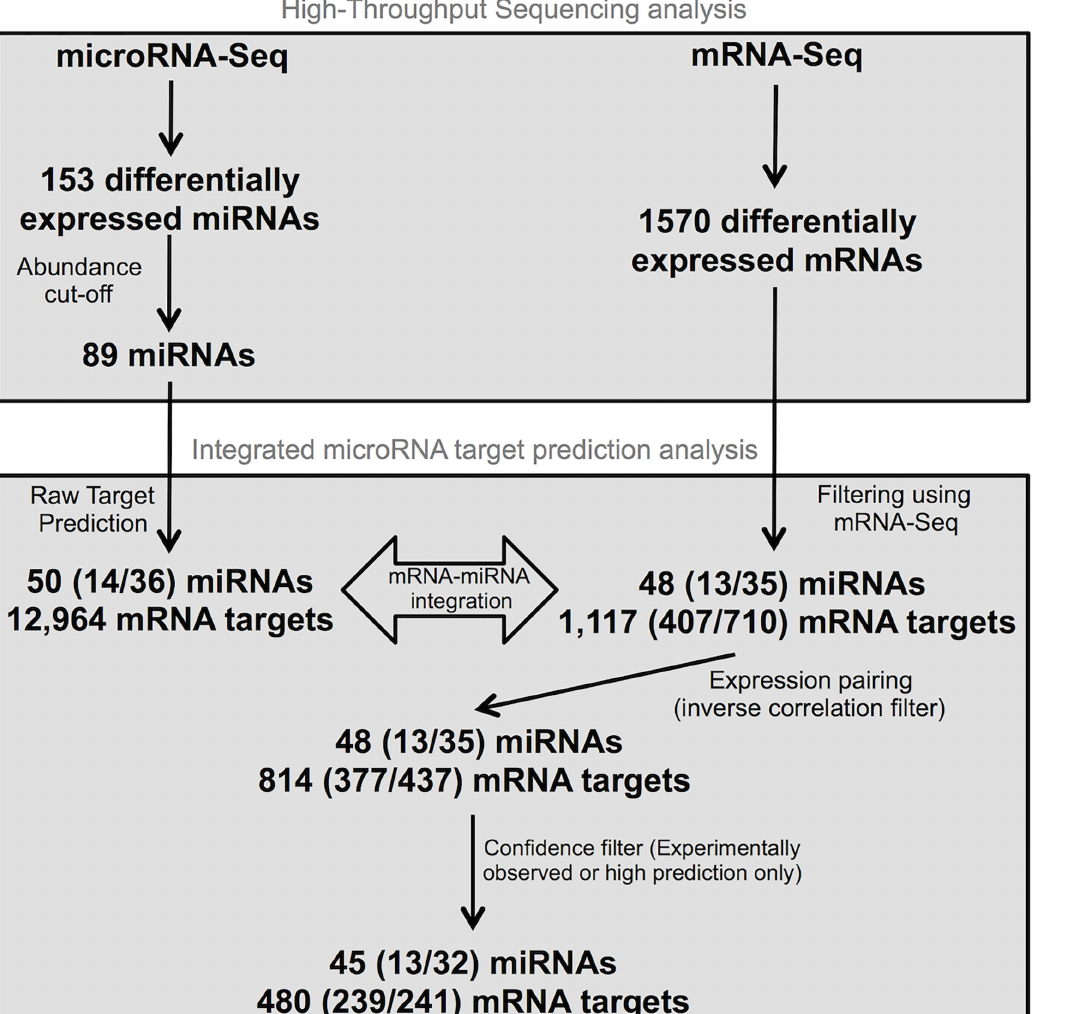
Fig 5. Workflow of integrated miRNA-mRNA association analysis using IPA. This experimental workflow shows the various filters used to associate miRNA-Seq and mRNA-Seq data. Numbers are presented as Total differentially expressed miRNAs or mRNAs